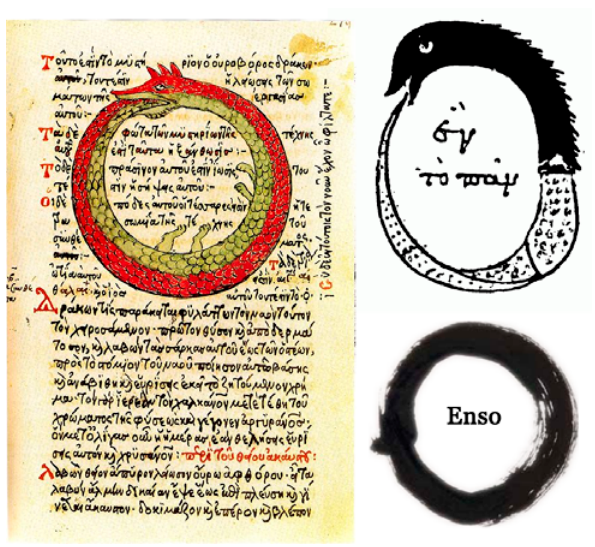
Figure 2. The mythical Ouroboros or snake biting its tail. Left : representation from a Greek manuscript, Codex Parisinus Graecus 2327, fol. 196, written in 1478 by Theodoros Pelecanos. Top right: representation from another Greek manuscript entitled Chryso- poeia of Cleopatra from Codex Marcianius Graecus 299 (Venice), written probably during the 11th century. Inside the Ouroboros, a text stating “Hen to Pan” translating as “All in One”. Bottom right: Zen’s ensō (Japanese world meaning “circle”) is a circle that is hand- drawn in one or two uninhibited brushstrokes to express a moment when the mind is free to let the body